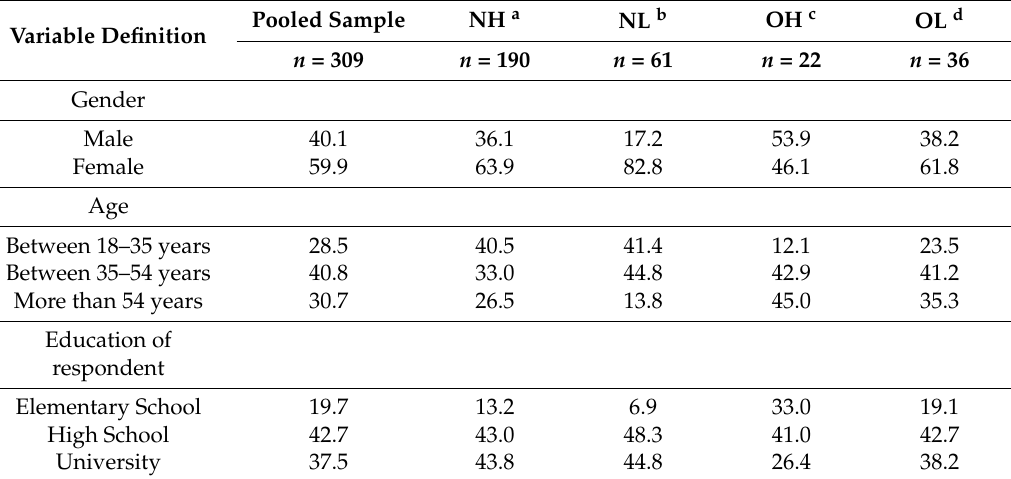
Table 2. Definition of socio-demographic variables of pooled sample and across the